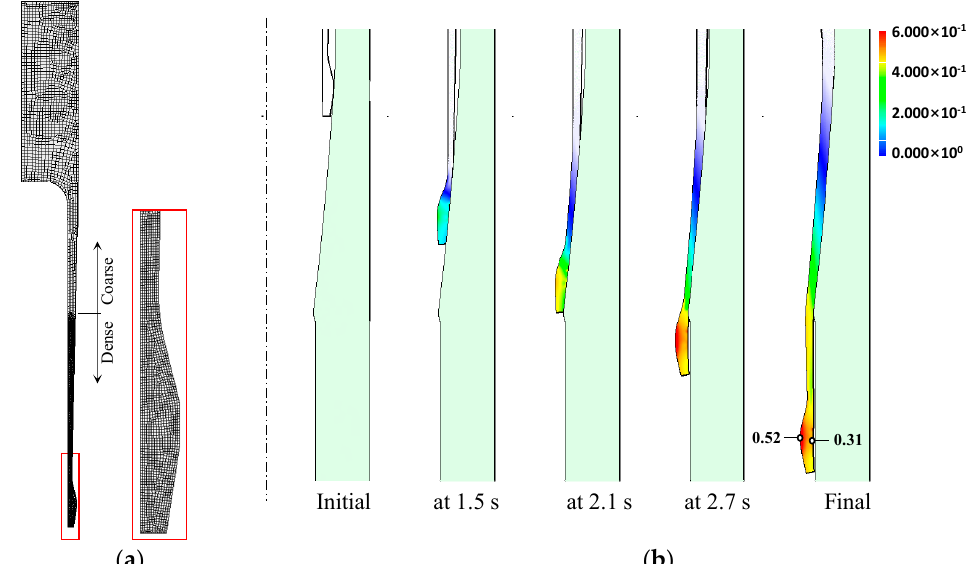
Figure 9. FE (Finite Element) analysis model and history of deformation: ( a ) FE analysis model and ( b ) effective strain distribution.